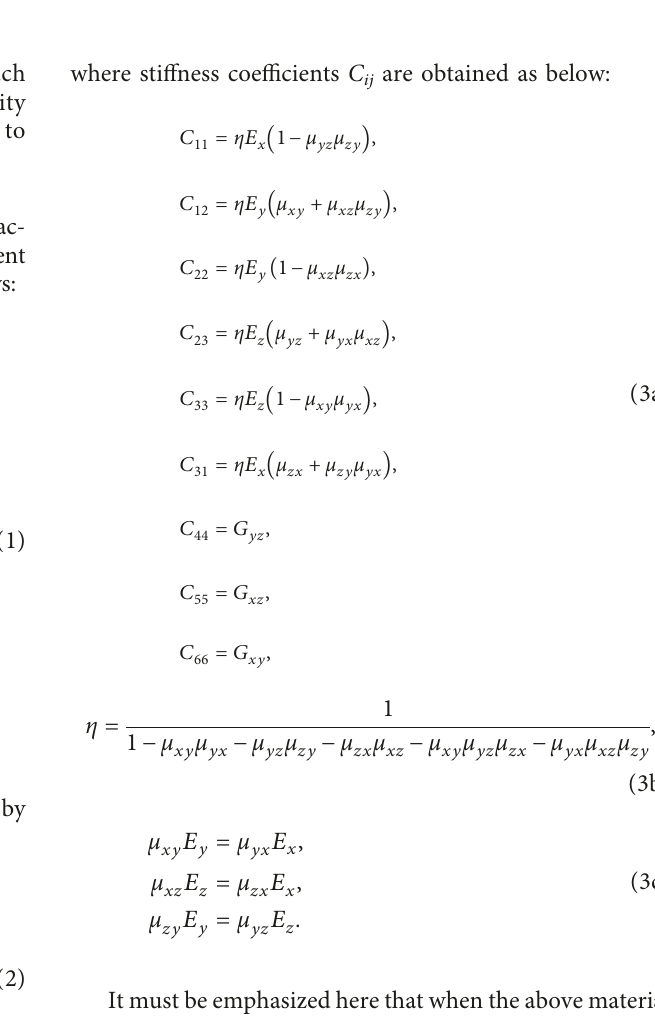
Figure 1: Schematic diagram of the 3D orthotropic rectangular plates: (a) geometry and coordinates; (b) boundary restraining